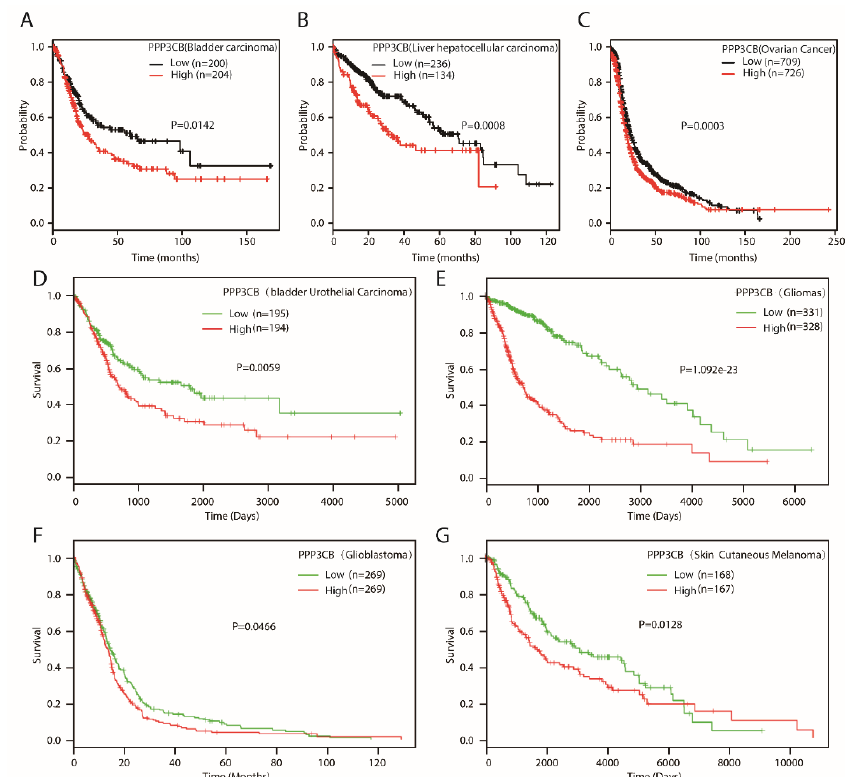
Figure A3. The high expression of PPP3CB is associated with worse survival in different cancer. ( A – C ) The analysis of survival for low PPP3CB expression patients and high PPP3CB expression patients in bladder carcinoma, liver hepatocellular carcinoma, and ovarian cancer using the open source Kaplan-Meier Plotter (http://kmplot.com/analysis). ( D – G ) The analysis of survival for low PPP3CB expression patients and high PPP3CB expression patients in bladder urothelial carcinoma, gliomas, glioblastoma, and skin cutaneous melanoma using the open source SurvExpress (http:// bioinformatica.mty.itesm.mx:8080/Biomatec/SurvivaX.jsp).